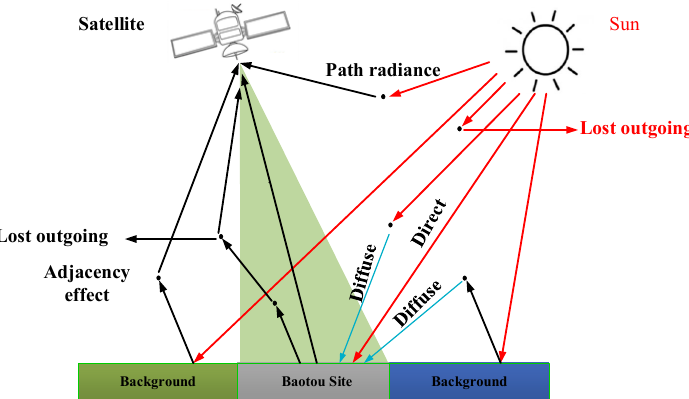
Figure 3. Light paths for radiation from the site (simplified to ignore multiple